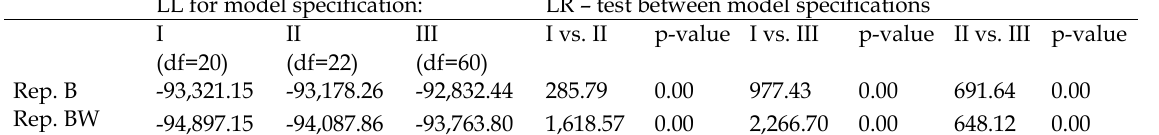
Table 9. Testing parameter stability in the repeated best and repeated BW